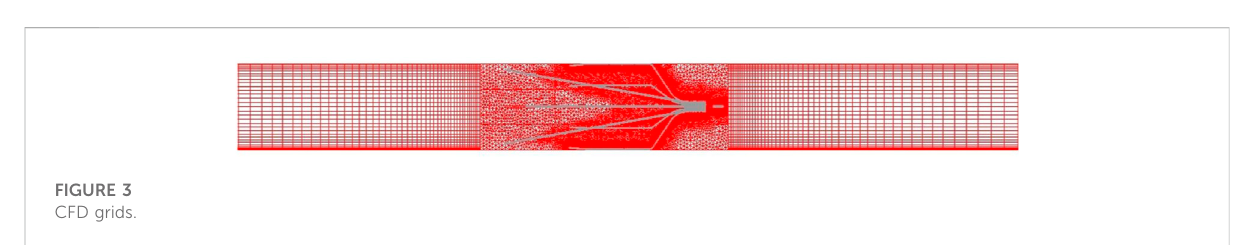
FIGURE 3 CFD grids.